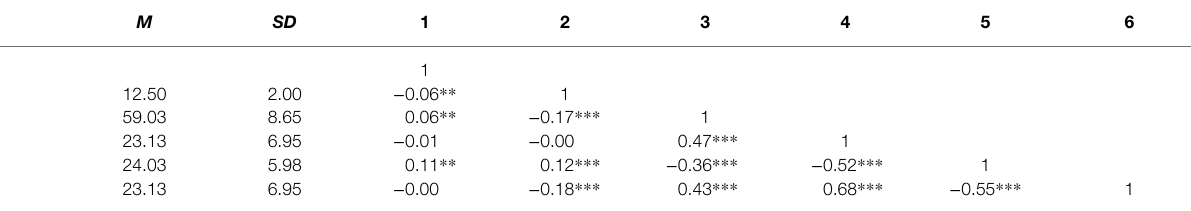
TABLE 1 | Descriptive statistics and bivariate correlations for all measures.